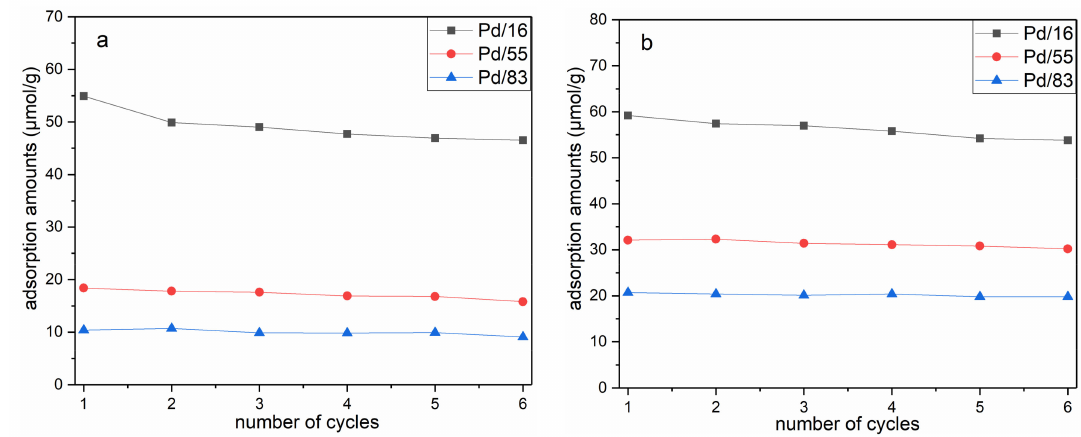
Figure 2. NO ( a ) and C 3 H 6 ( b ) adsorption amounts for the adsorption–desorption cycles of each